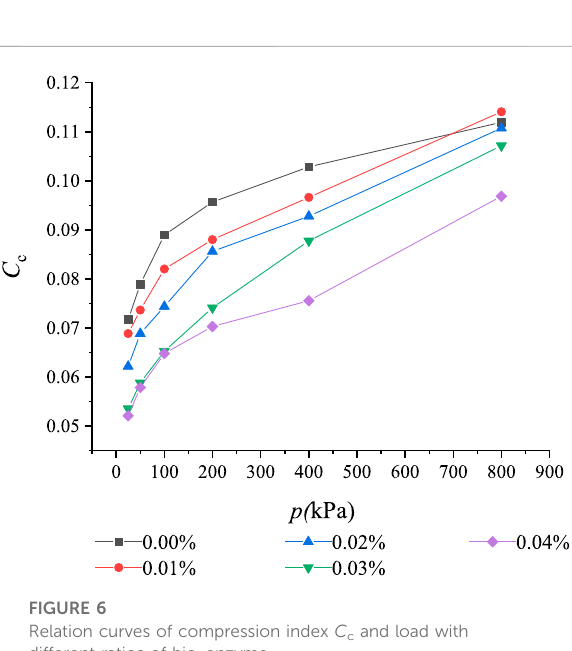
FIGURE 5 Relation curves between the secondary consolidation coef fi cient C a and load with different ratios of bio-enzyme.